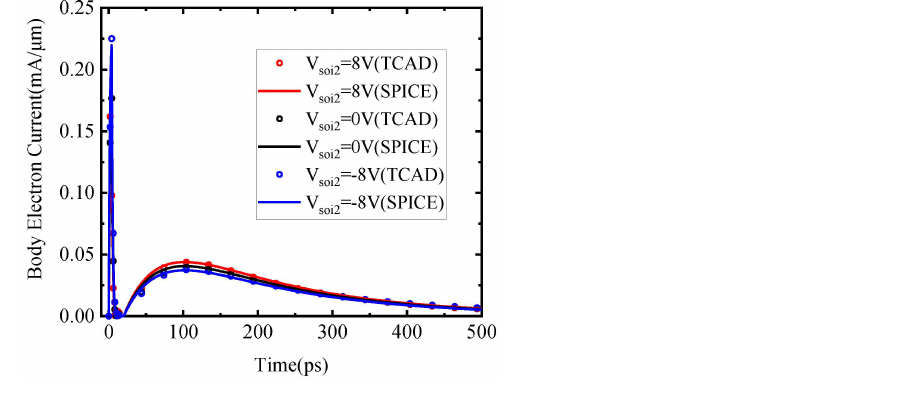
Figure 11. Prompt current and diffusion current with different back-gate voltages of the SPICE model and TCAD simulation.